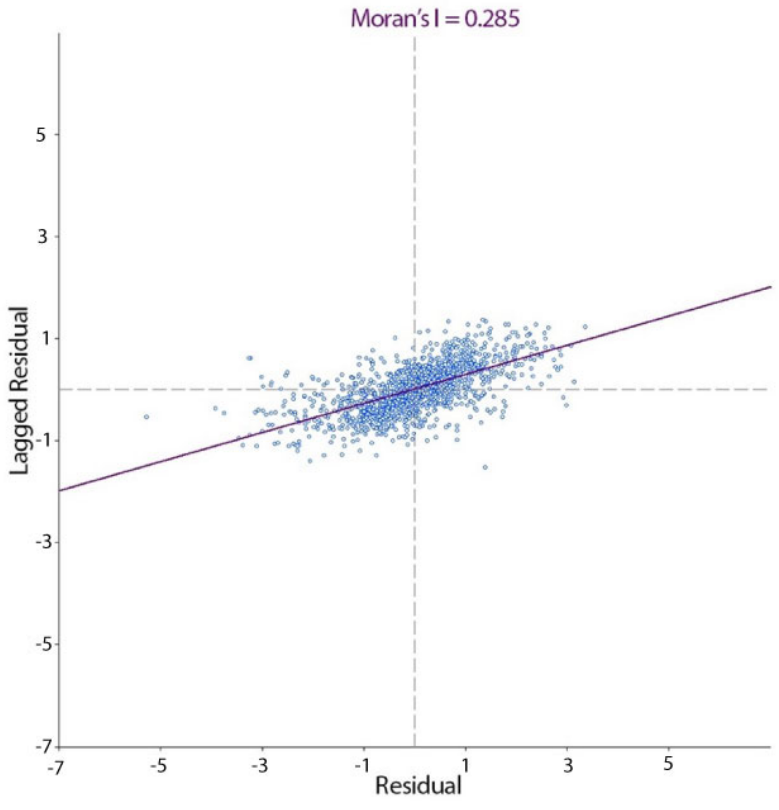
Figure 9. Moran index plot for the GWR model.